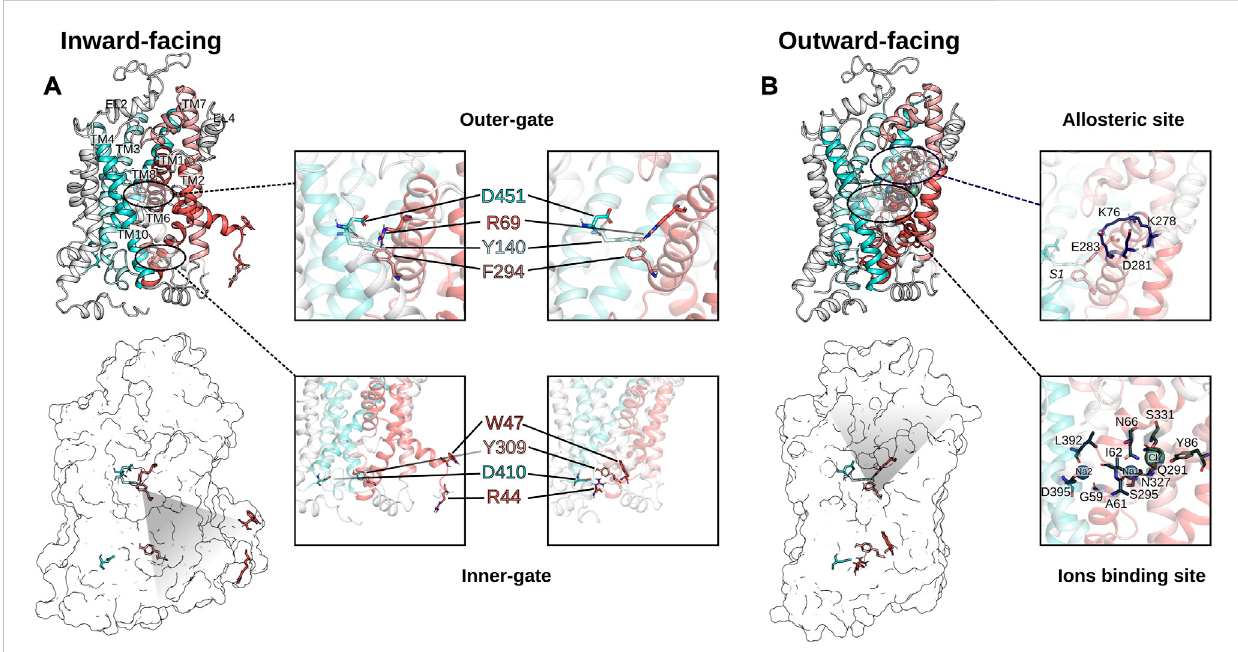
Comparison of the inward-facing conformation (A) and the outward facing conformation (B) of GAT1. The inward-open and the outward-open conformations of GAT1 are shown in secondary structure rendering to visualize the TM helices (scaffold domain in cyan colors, bundle domain using red colors) andas transparentsurfacerenderingto highlight theresiduesoftheextracellular gateand theintracellular gate. The insertszoom-inon theouter and the inner gate to highlight the structural differences of the two conformations. On the right of (B) are shown two zoom-in inserted on the allosteric site S2 and on the ion binding residues,